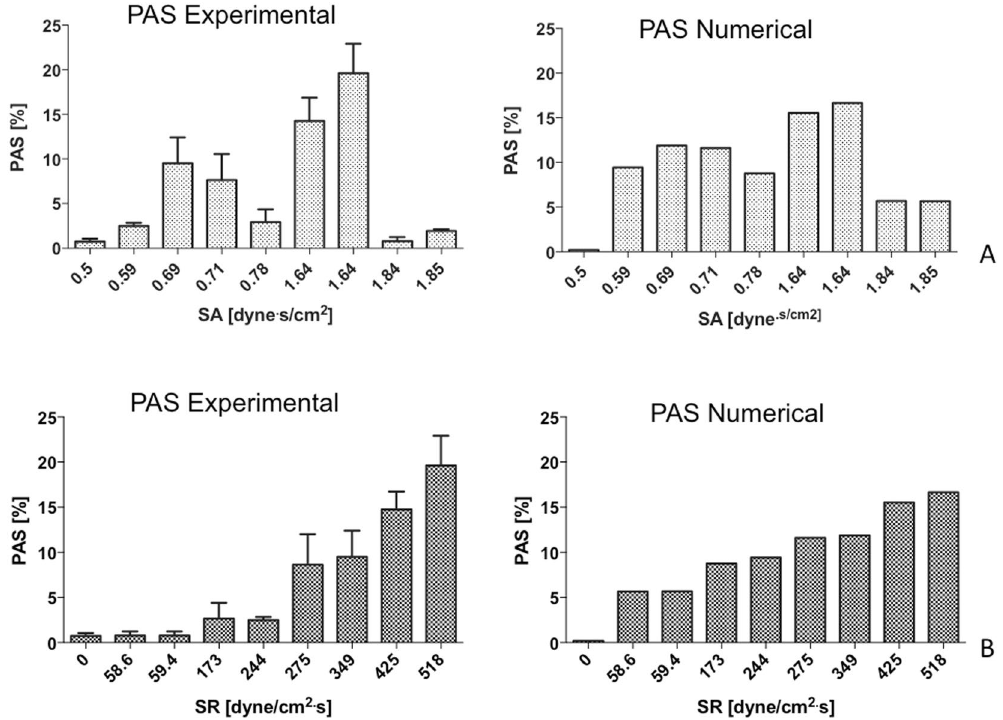
Figure 6. PAS values (mean ± SD) obtained after a 10-min stimulation period are plotted against values of SA ( A ) and SR ( B ) characterizing the curves of our data set; SA and SR are reported as for 1 stimulation cycle. Numerical PAS values are reported as computed according to ref. 23.